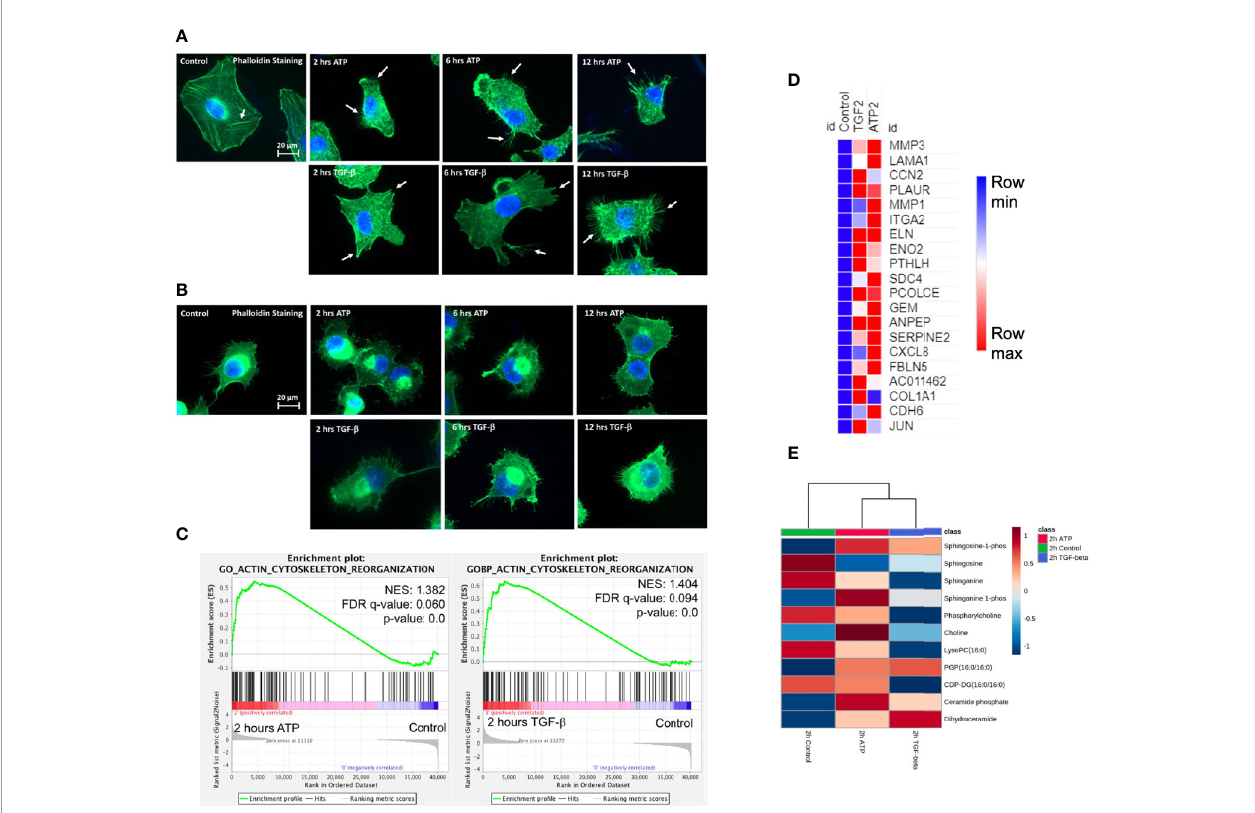
FIGURE 4 | Extracellular ATP induces time-dependent formation of fi lopodia similar to TGF- b con fi rmed by transcriptomics and metabolomics analyses. Human NSCLC A549 and H1299 cells were grown on coverslips in cell culture plates were treated with either eATP or TGF- b for various hours. After treatment, fl uorescence microscopy was used to visualize time-dependent formation of fi lopodia-like protrusions in eATP- or TGF- b -treated A549 and H1299 cells. NES: normalized enrichment score. (A, B) Fluorescence microscopy of time-dependent formation of fi lopodia-like protrusion formation in eATP-treated A549 cells (A) and H1299 cells ( B ). Untreated and TGF- b treated cells served as negative and positive controls. Arrows point to distinctive protrusions of the cells. The quanti fi cation of the fi lopodia formation can be found in the Supplemental Figure S4 . (C) Transcriptomics GSEA plots for the “ GO Actin Cytoskeleton Reorganization ” signature derived from RNAseq data, 2 hours ATP compared to control (top) and 2 hours TGF- b compared to control (bottom). (D) Heat mal of the top 20 enriched genes in common between ATP and TGF- b for actin cytoskeleton reorganization. The FPKM values of three replicates of each gene are shown in Supplemental Table 4 . (E) Heatmap of metabolomics analysis showing metabolites involved in actin cytoskeletal rearrangement altered by ATP and TGF- b in A549 cancer cells after 2 hours of